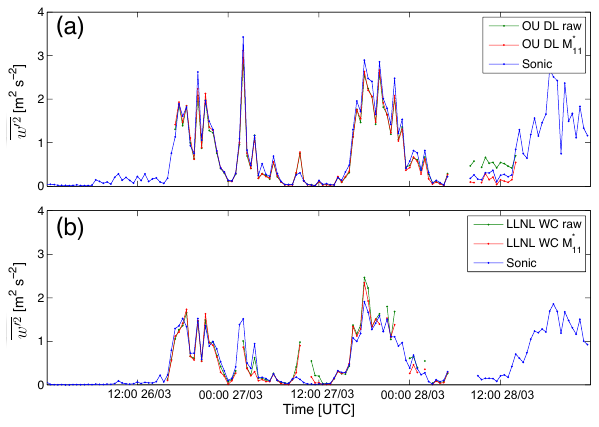
Figure 10. Time series comparison of w (cid:48) 2 measurements from the OU DL at 300m (a) and the LLNL WC at 100m (b) over the ex- perimental time period. For each lidar, the raw measurement is cal- culated directly from the w measurements and is identical to M 11 . Sunrise and sunset were approximately 12:50 and 00:20UTC re- spectively. Data were removed at ≈ 07:00UTC on 28 March due to contamination from